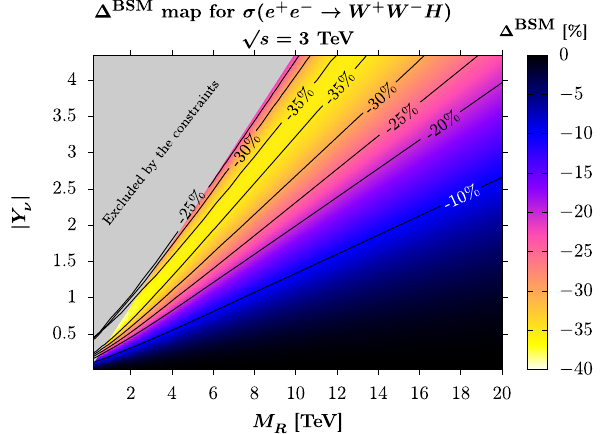
Fig. 3 Contour map of the neutrino corrections Δ BSM (in percent) to the W + W − H production cross-section at a 3 TeV electron-positron collider, using a − 80% polarised electron beam, as a function of the seesaw scale M (in GeV) and | Y ν | in the μ -parameterisation, using a R X diagonal Yukawa texture and a hierarchical heavy neutrino mass matrix with the parameters defined in Eq. (7). The grey area is excluded by the